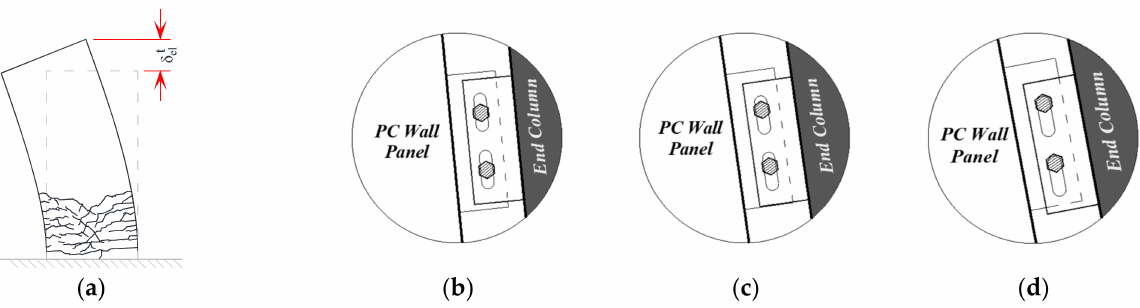
Figure 11. Vertical bearing of Tensile side (VT). ( a ) Longitudinal elongation of tensile side; ( b ) Before slip; ( c ) Slipping; ( d ) Bolt